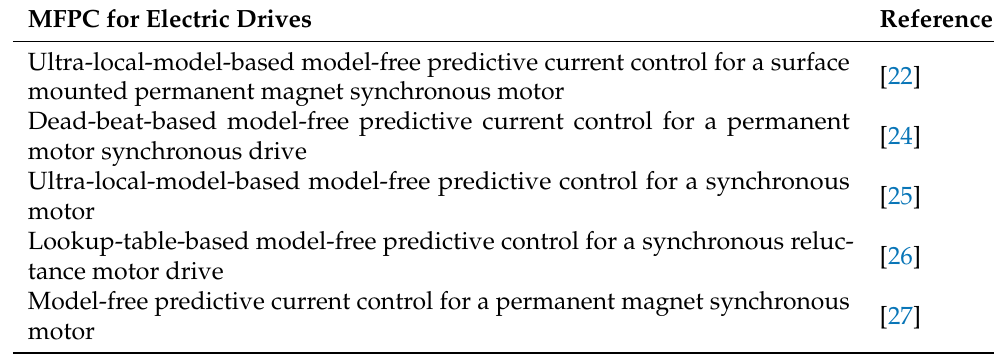
Table 3. Research papers on the application of model-free predictive control in electric